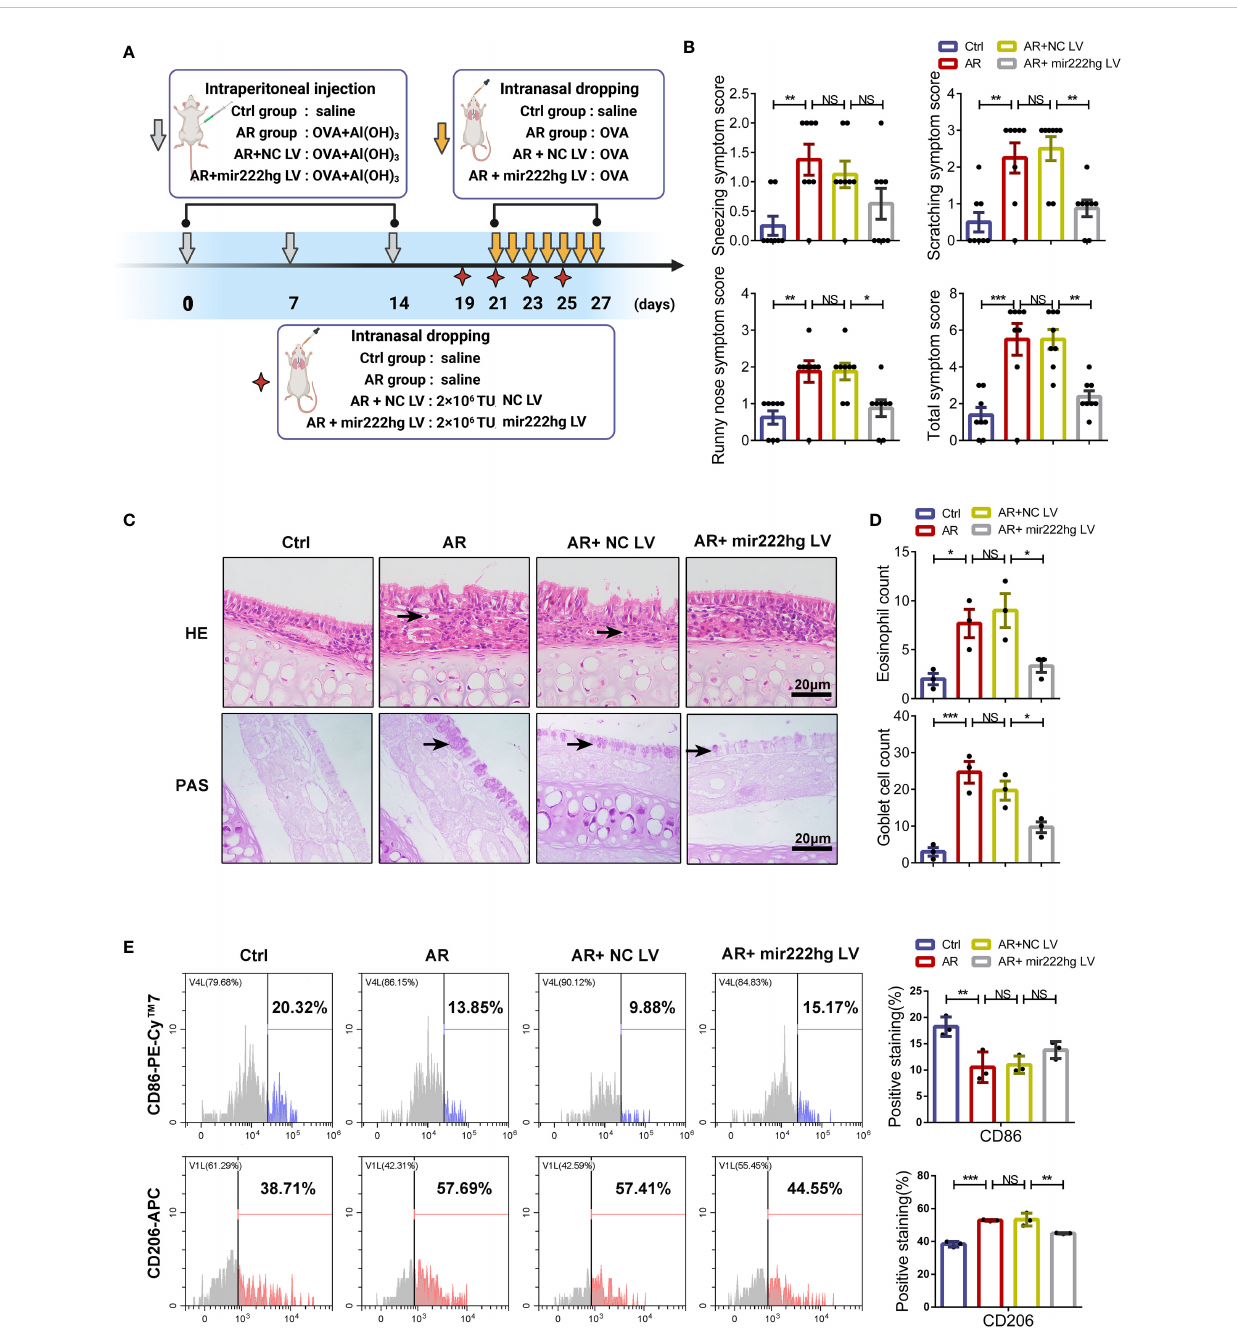
FIGURE 9 Intranasal administration of mir222hg – overexpressing lentivirus alleviated the allergic in fl ammatory response in AR mice (A) A schematic illustrating the experimental protocol for the establishment of the AR animal model and the intranasal administration of mir222hg – overexpressing lentivirus. (B) The partial and total AR nasal symptom scores of mice in the Ctrl, AR, AR + NC LV, and AR + mir222hg LV groups. (C) Representative images of nasal mucosa stained with HE and PAS. Eosinophils and goblet cells were labeled by arrows. Scale bars, 20 m m. (D) The eosinophil and goblet cell count in the nasal mucosa of mice in each group. (E) Representative fl ow cytometry histograms (left) and statistical analysis (right) showing the surface expression of CD86 and CD206 in macrophages isolated from the spleens of mice in each group. Each point represents data from one individual sample. Data are shown as the mean ± SEMs (n= at least 3 samples per group). Data are merged from three independent experiments. Statistical signi fi cance was calculated by two-way ANOVA followed by Sidak ’ s multiple comparisons test. * p< 0.05, ** p< 0.01, *** p< 0.001, NS no signi fi